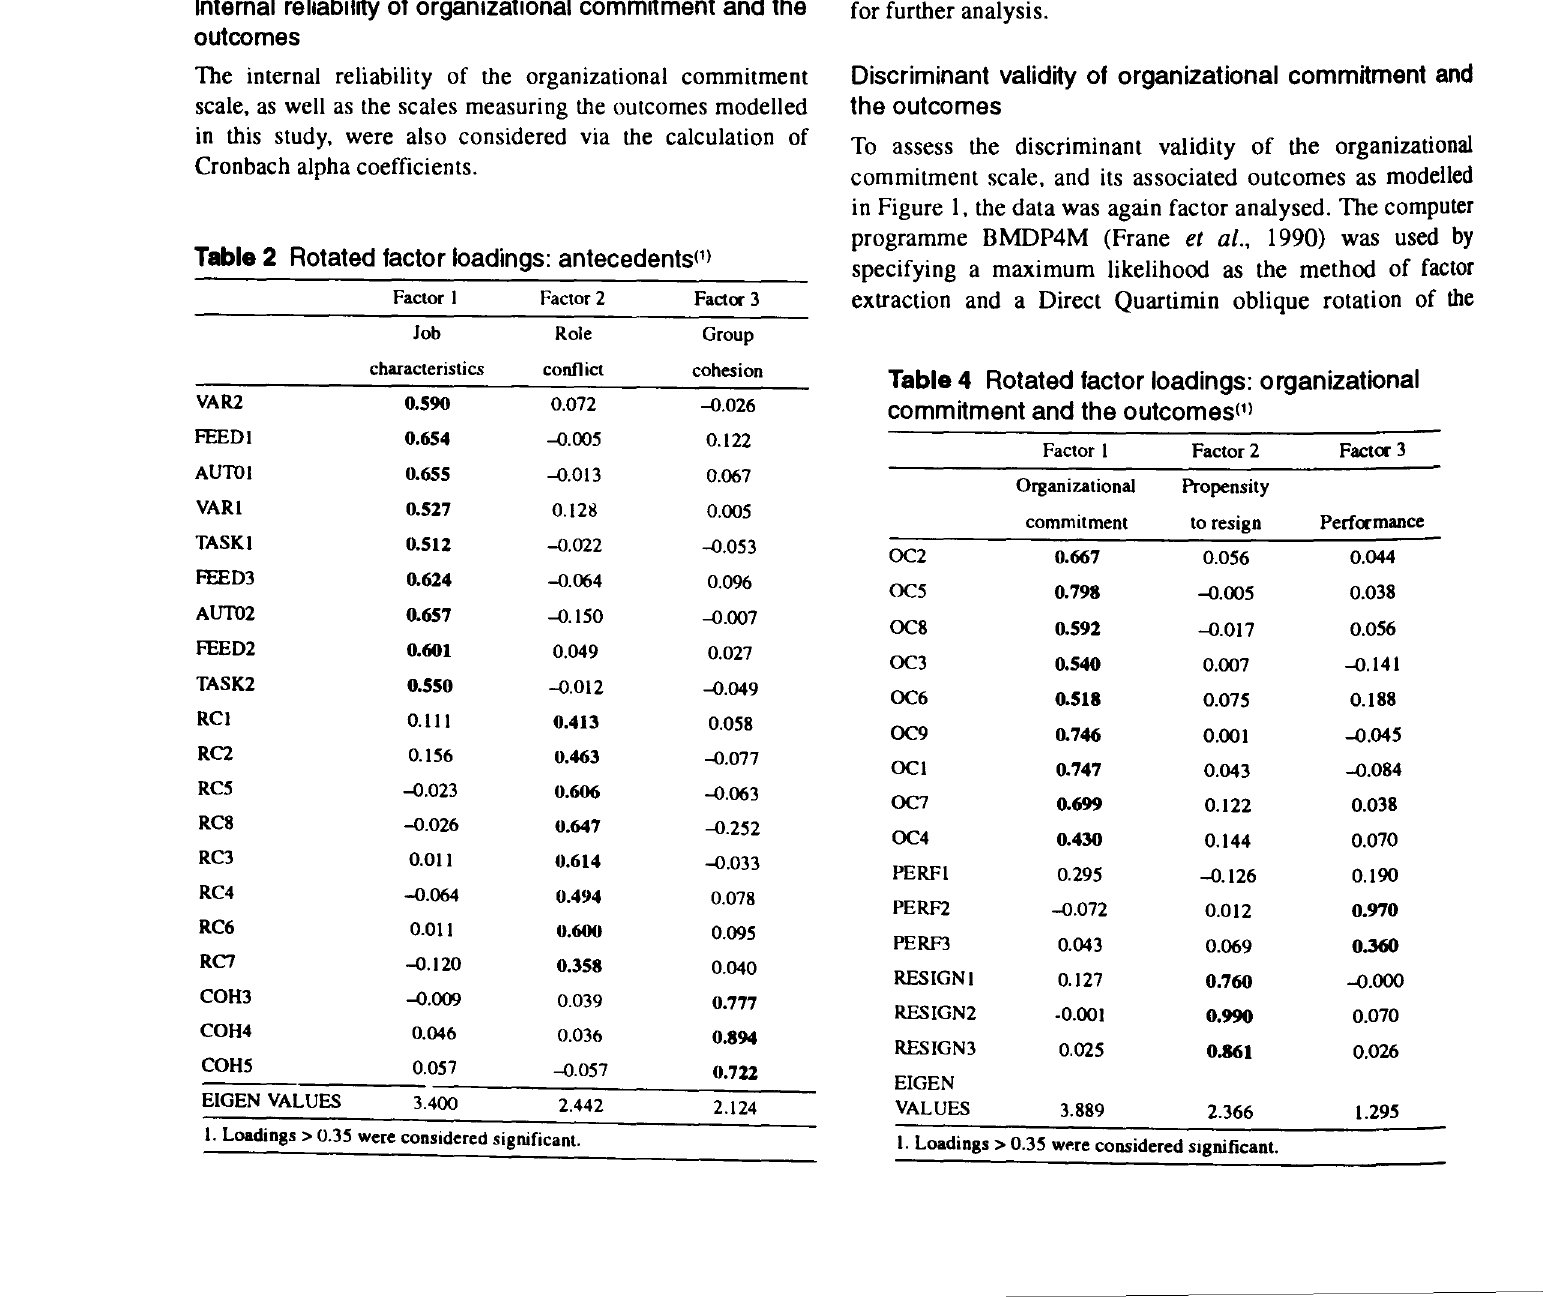
Table 2 Rotated factor loadings: antecedents< 1 >